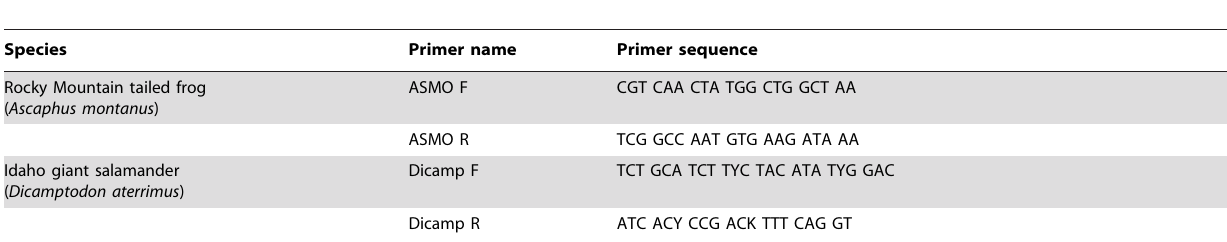
Table 2. Primer sequences for species-specific amplification of short fragments of cytochrome b